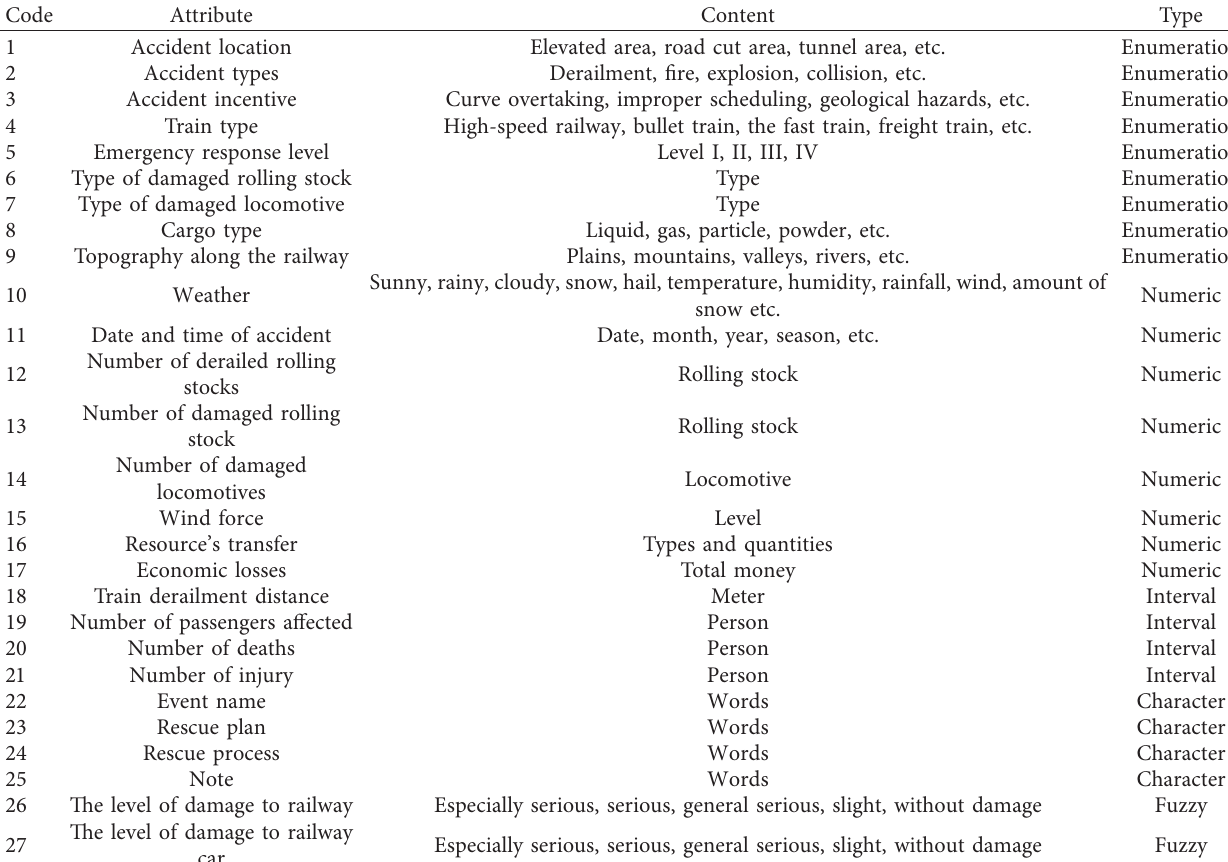
Table 1: Case presentation framework of railway